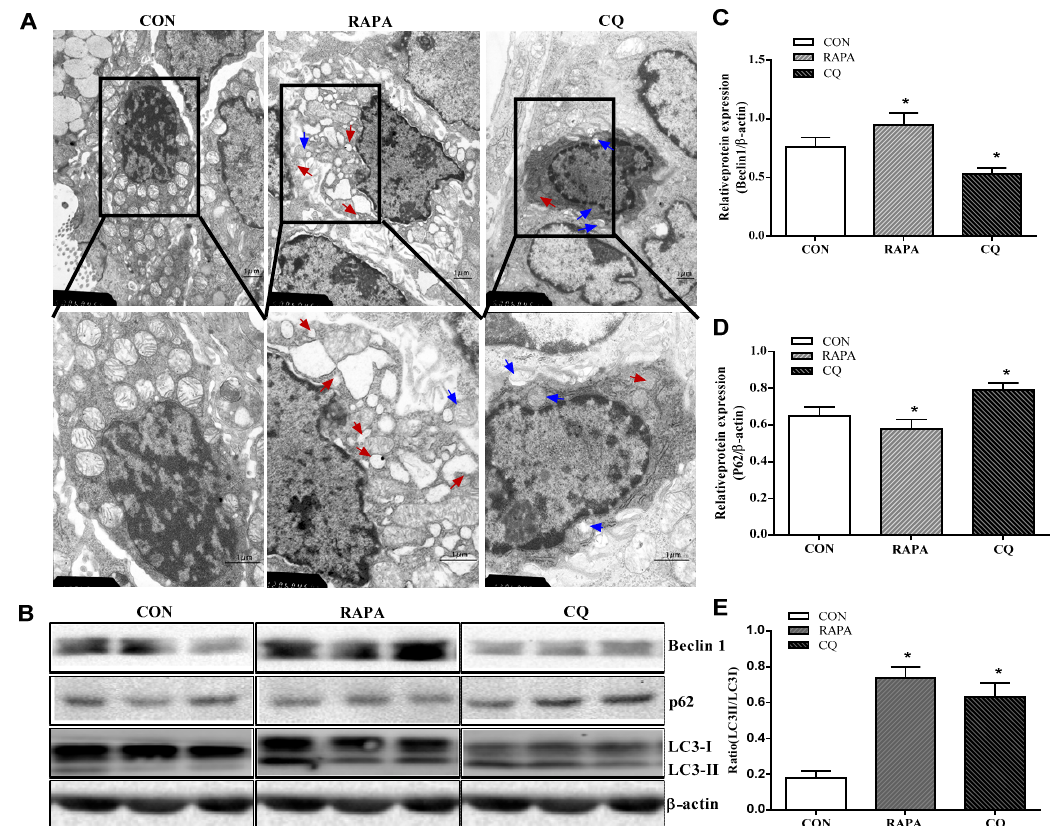
Figure 1. Autophagy validation in the jejunum of weaning piglets. ( A ) Observation of autophagy bubbles by transmission electron microscopy. Red arrows indicate autolysosomes, blue arrows indicate autophagosome. ( B ) Western blot results. ( C ) Beclin1 protein abundance. ( D ) p62 protein abundance. ( E ) LC3B protein abundance (the ratio of LC3II and LC3I). Dietary treatment: RAPA, rapamycin; CQ, chloroquine; CON, normal saline. Data are expressed as means ± SEM ( n = 6), three models chosen, all values are expressed in relation to the control. * p < 0.05 vs. control.